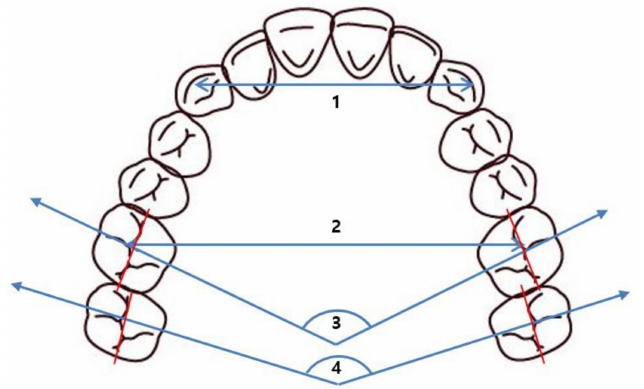
Figure 6. Model measurements. 1, ICW (intercanine width); 2, IMW (intermolar width); 3, Rotation of first molar; 4, Rotation of second